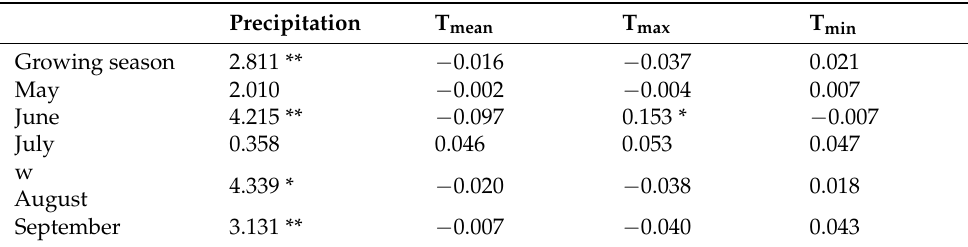
Table 3. Change trends in T mean ( ◦ C/year), T min ( ◦ C/year), T max ( ◦ C/year) and precipitation (mm/year) of marshes in Sanjiang Plain during the growing season from 2000 to 2020. Precipitation T mean T max T min Growing season 2.811 ** − 0.016 − 0.037 0.021 May 2.010 − 0.002 − 0.004 0.007 June 4.215 ** − 0.097 0.153 * − 0.007 July 0.358 0.046